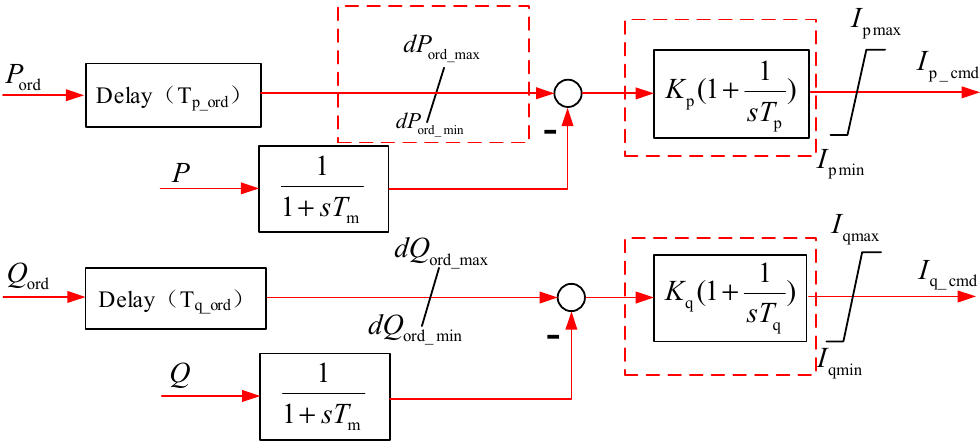
Figure 7. Control structure diagram of energy storage unit.